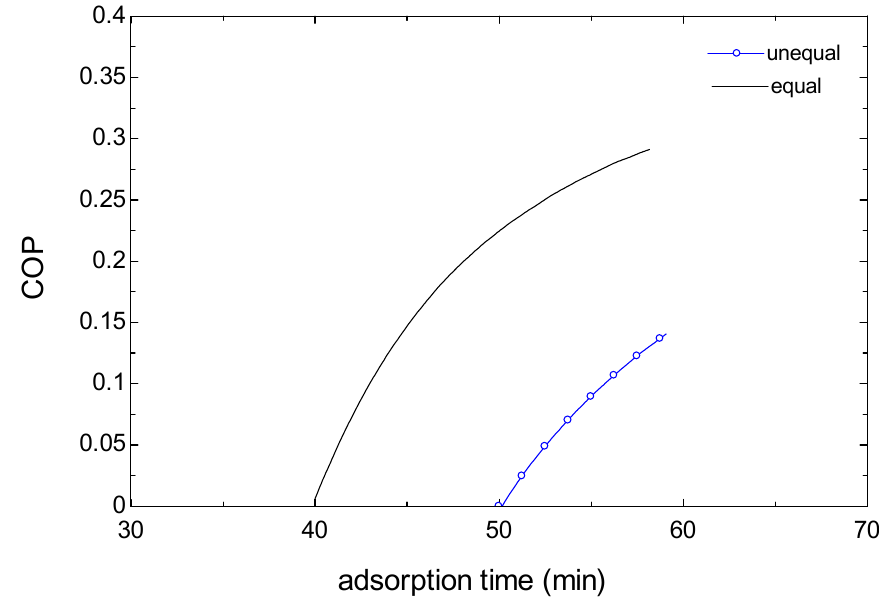
Figure 10. Performance profile.